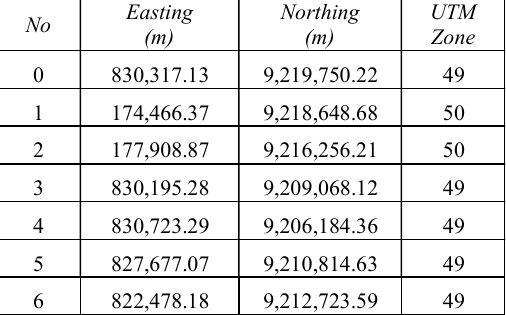
Table 3. Coordinates of Wave Potential from Eq.4